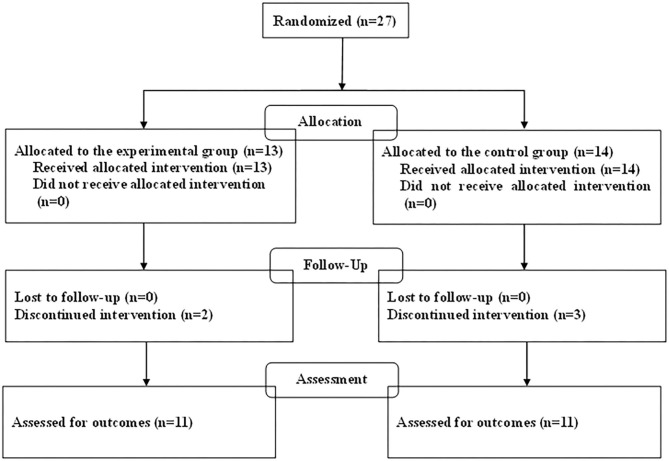
Enrollment flowchart following CONSORT guidelines.